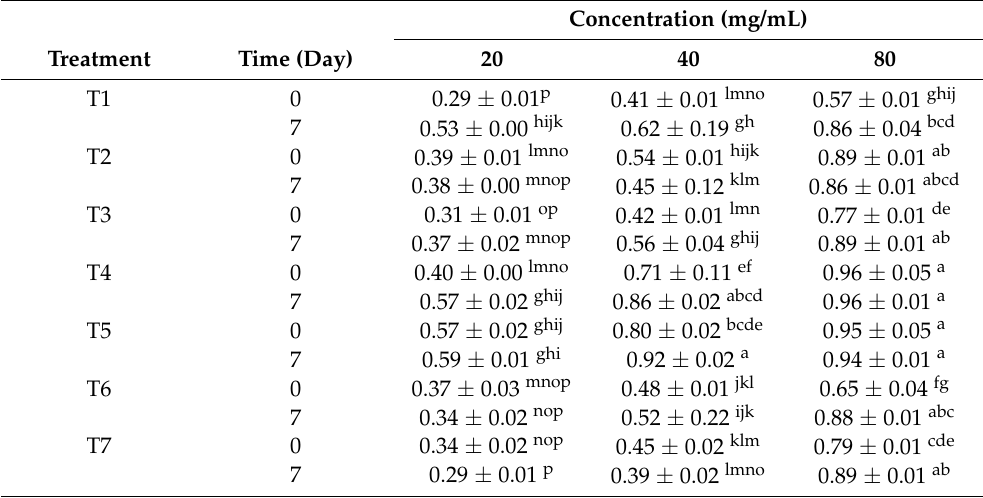
Table 3. Antioxidant activity as Ferric-Reducing Antioxidant Power (FRAP *) of peptide extracts from fermented milk samples after fermentation (day 0) and after 7 days of